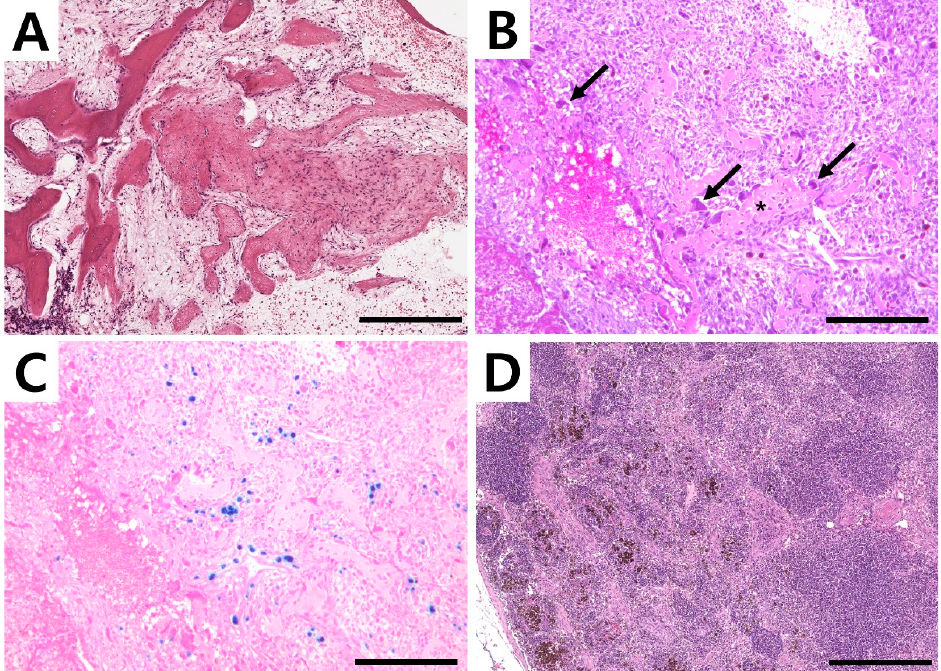
Figure 4. Histological appearance of the lesion. ( A ) Areas of fibrous tissue proliferation and reactive bone (H&E, scale bar = 500 µm). ( B ) Cavernous spaces delimited by septa of connective tissue with the presence of giant multinucleated cells. Note bone spicules (asterisk) with osteoblastic activity (white arrow) and presence of osteoclasts (black arrow) (H&E, scale bar = 200 µm). ( C ) Macrophages phagocytosing hemosiderin (Prussian blue, scale bar = 200 µm). (H&E, scale bar = 200 µm). ( D ) Lymph node with hemosiderin-laden macrophage (H&E, scale bar = 500 µm).